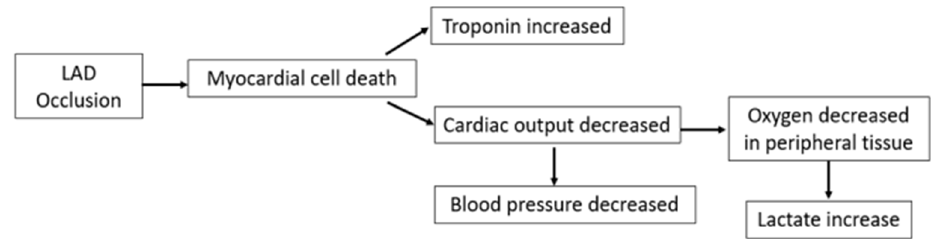
Figure 5. Acute changes after AMI onset. Schematic depicting acute hemodynamic and biomarker changes after an acute myocardial infarction was induced in pigs by occlusion of the left anterior descending artery (LAD).